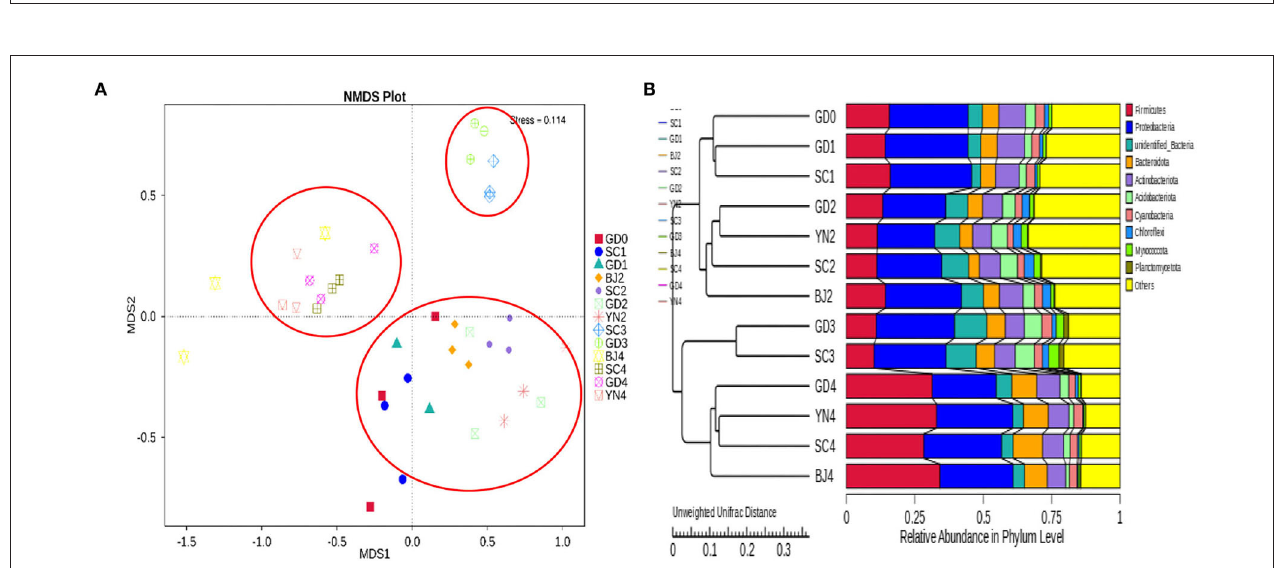
FIGURE 8 | Heatmap depicting relative species abundance. Plotted by sample name on the X-axis and the Y-axis represents the genus. The cluster tree on the left side of the graph is a species cluster tree.